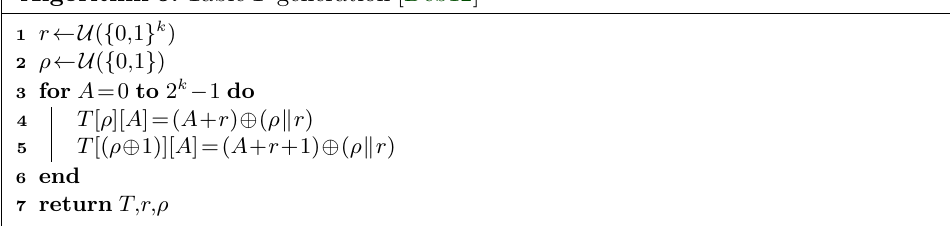
Algorithm 5: Table T generation